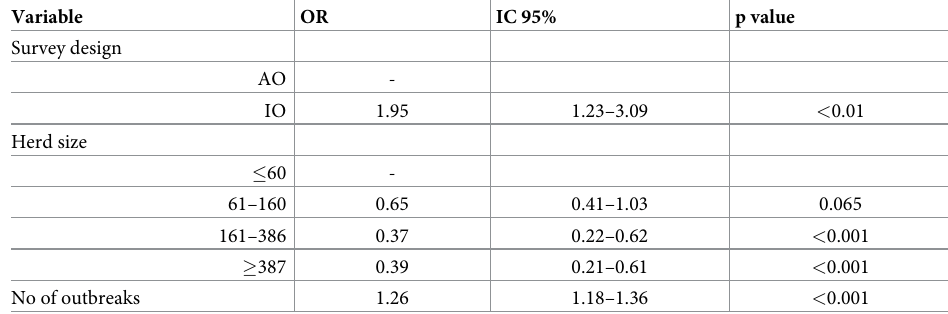
Table 4. Multivariable analysis for the exposure variables relative to the animal seropositivity